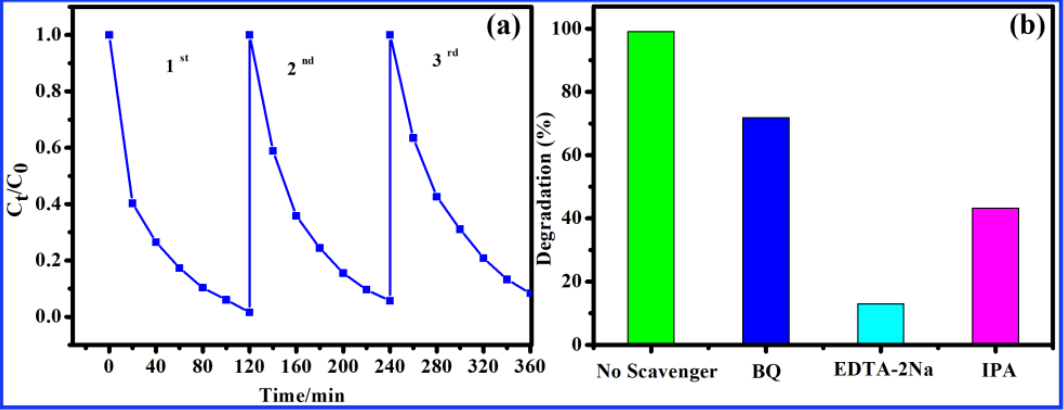
Figure 7. ( a ) Cycle experiments for degradation of MB over 10 wt.% CN-200/Z-500; ( b ) Influence of